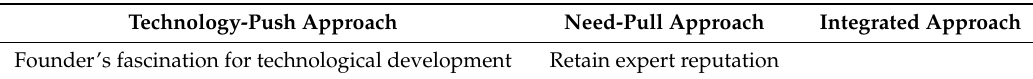
Table 8. Summary of the adoption drivers for